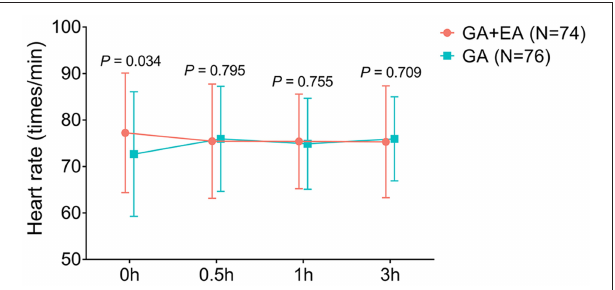
FIGURE 6 | HR. Comparison of HR between GA + EA group and GA group. HR, heart rate; h, hour; GA, general anesthesia; EA, epidural anesthesia.